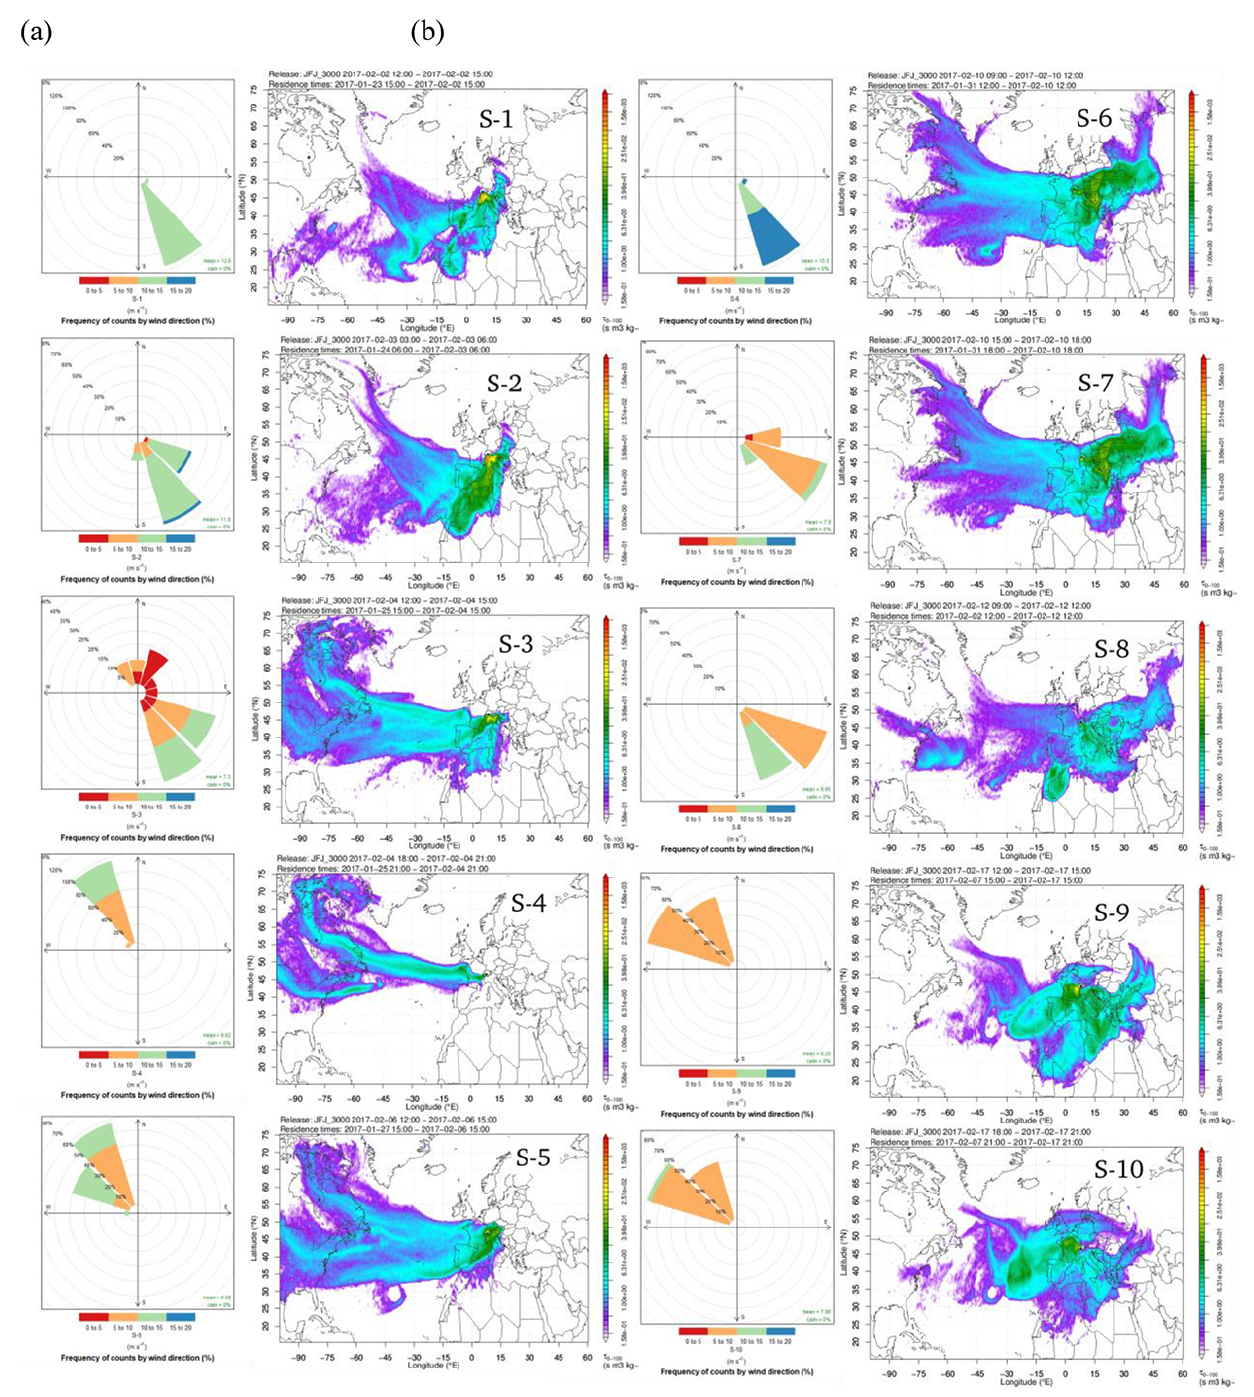
Figure 3. Wind rose (a) and footprint plots (b) calculated with the FLEXPART model, http://lagrange.empa.ch/FLEXPART_browser/ (last access: 17 January 2018) (Stohl et al., 1998, 2005; Stohl and Thomson, 1999; Seibert and Frank, 2004). Horizontal wind direction and speed were obtained from the Federal Office of Meteorology and Climatology (MeteoSwiss; https://www.meteoswiss.admin.ch, last access: 17 October